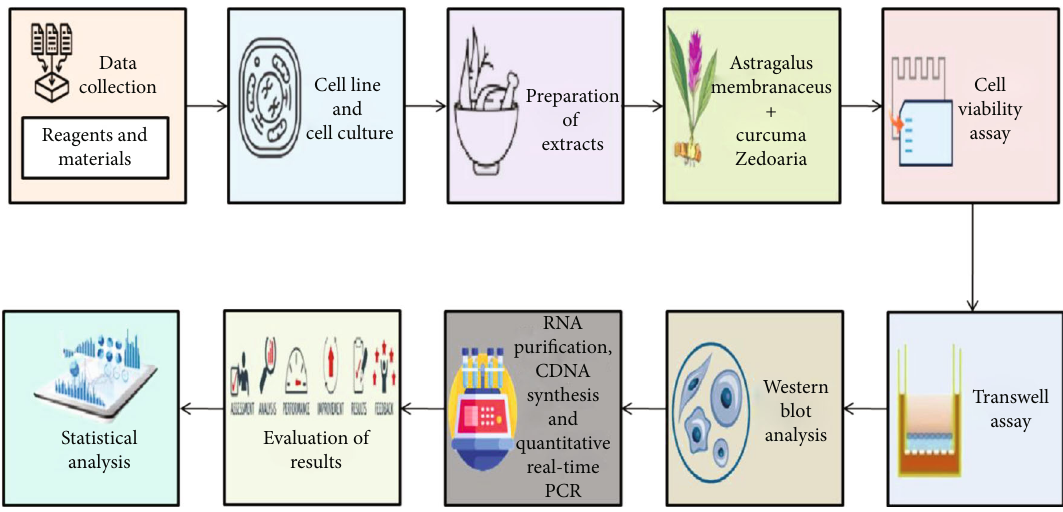
Figure 1: Flow of the methodology